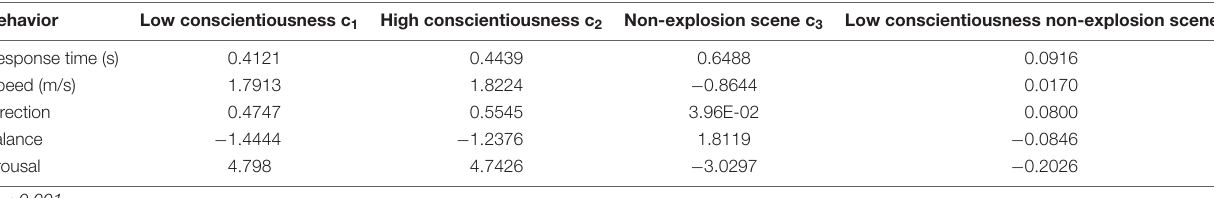
TABLE 12 | Interaction of conscientiousness and experimental scene on individual emotional impact and escape behavior. Behavior